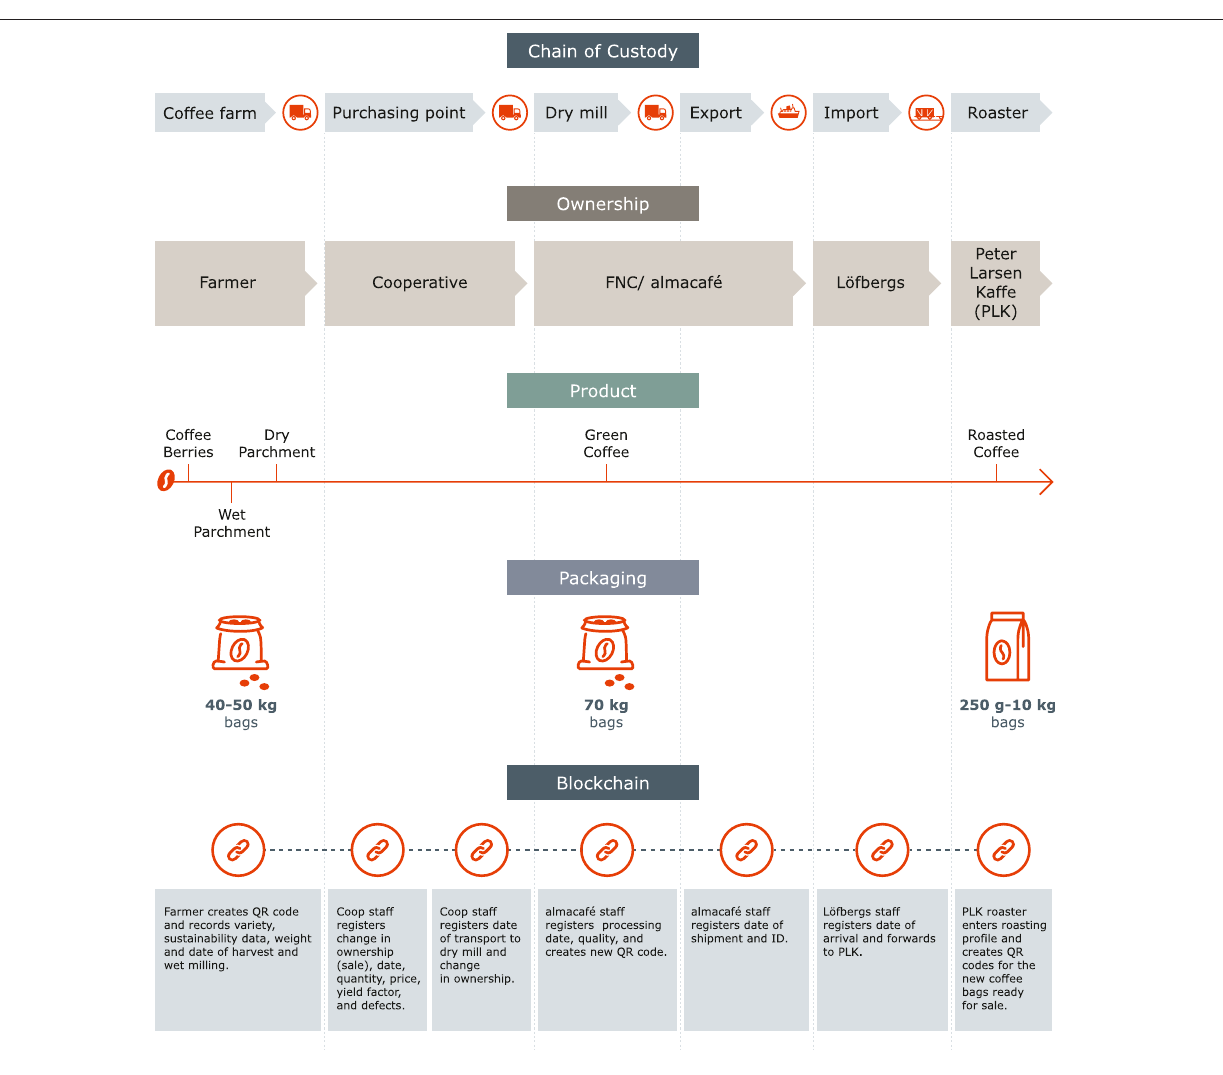
FIGURE 1 | Overview of a coffee supply chain with blockchain